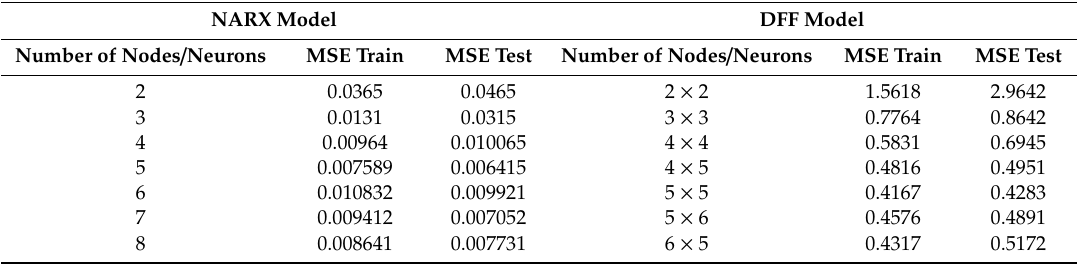
Table 4. Best-obtained results vs.the hidden layer’snumber of